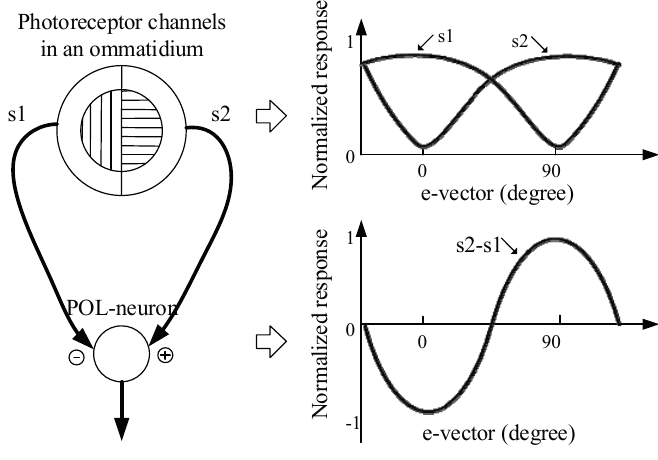
Figure 1. The processing of polarized-light information in the insect nervous system. The two channels in an ommatidium are tuned to orthogonal polarization directions. The e-vector response of the photoreceptor (s1,s2) have a logarithmic intensity characteristic [11]. The POL-neuron response represents a difference between s1 and